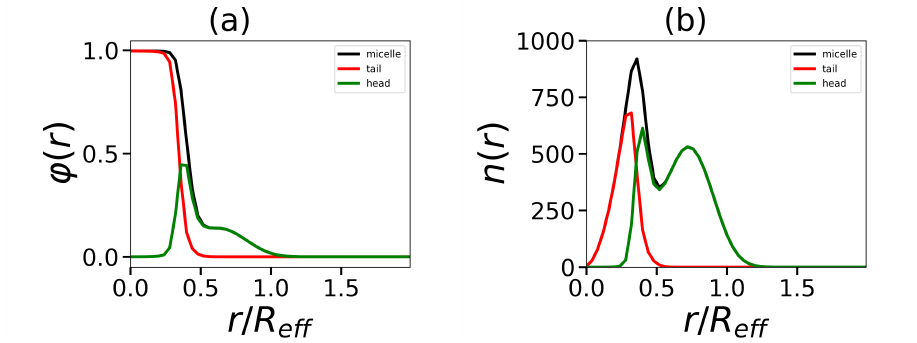
Figure 11. The radial distributions of segments in the hydrophobic core and hydrophilic corona, as well as the total distribution: ( a ) the volume fraction ϕ ( r ) and ( b ) the number distribution n ( r ) . All cases correspond to the same number of tails t = 2, tail length N t = 60, and generation number G =